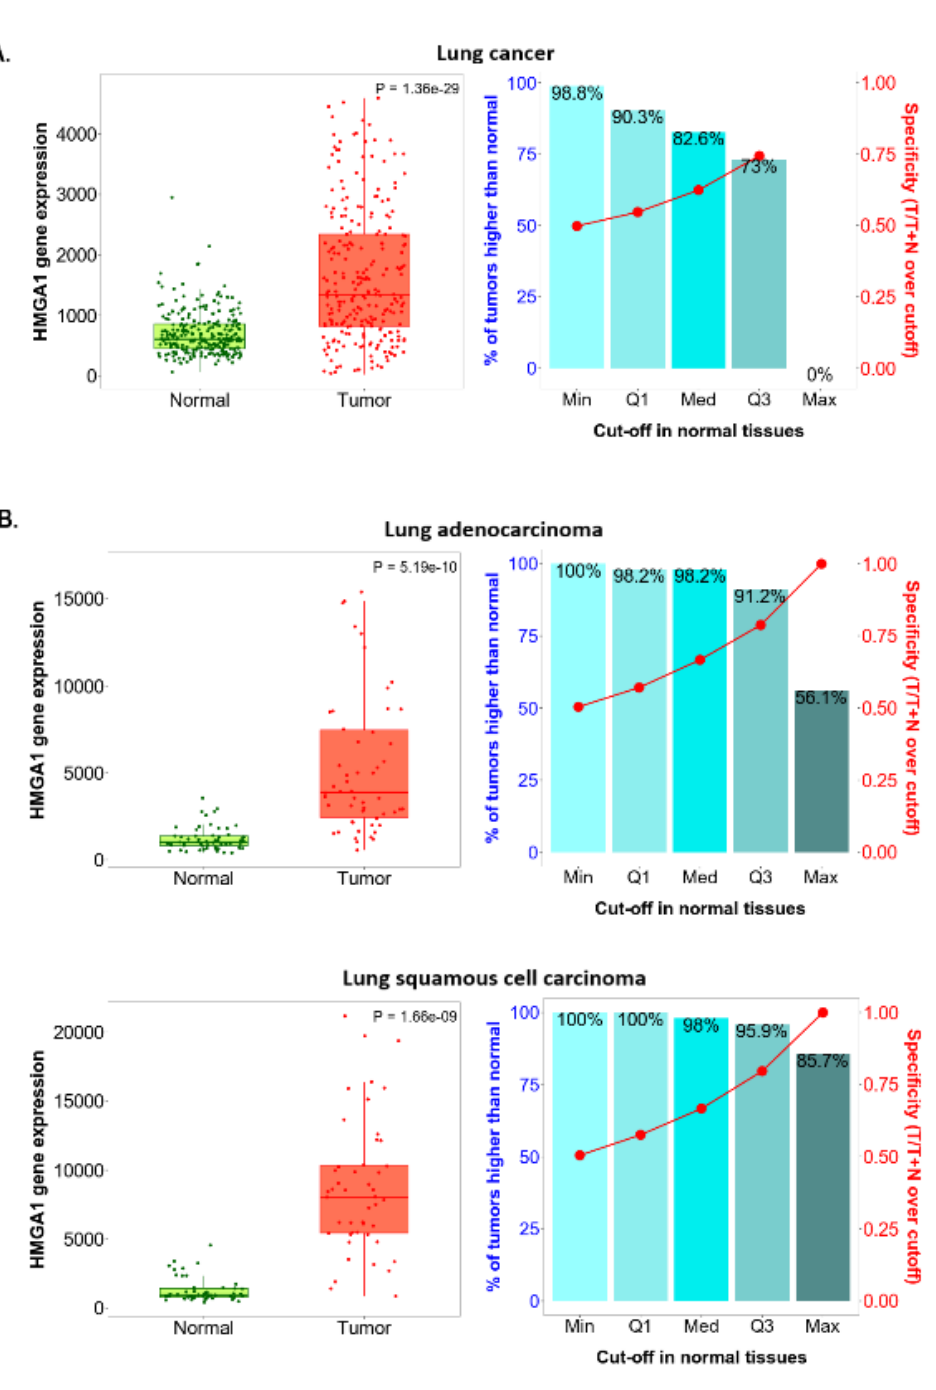
Figure 4. HMGA1 expression level in paired tumor and adjacent normal tissue by TNMplot. ( A ) Gene chip data for lung cancer. ( B ) RNA-Seq data for adenocarcinoma and squamous cell carci- noma.